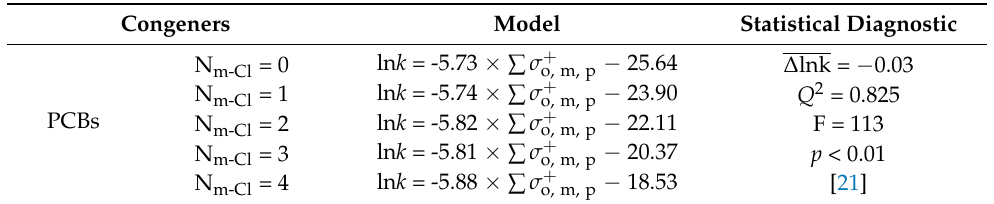
Table 2. The model based on ∑ σ + o, m, p and meta-substituent grouping for predicting • OH oxidation